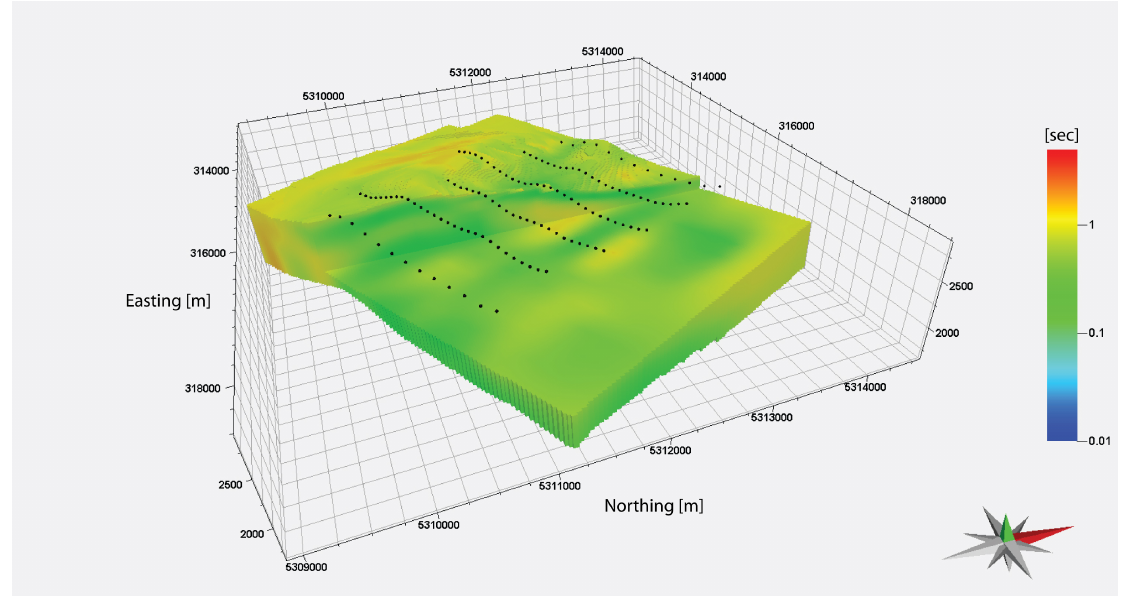
Figure 10. A 3D view of the 3D time constant model recovered from 3D inversion of pole–dipole IP data.